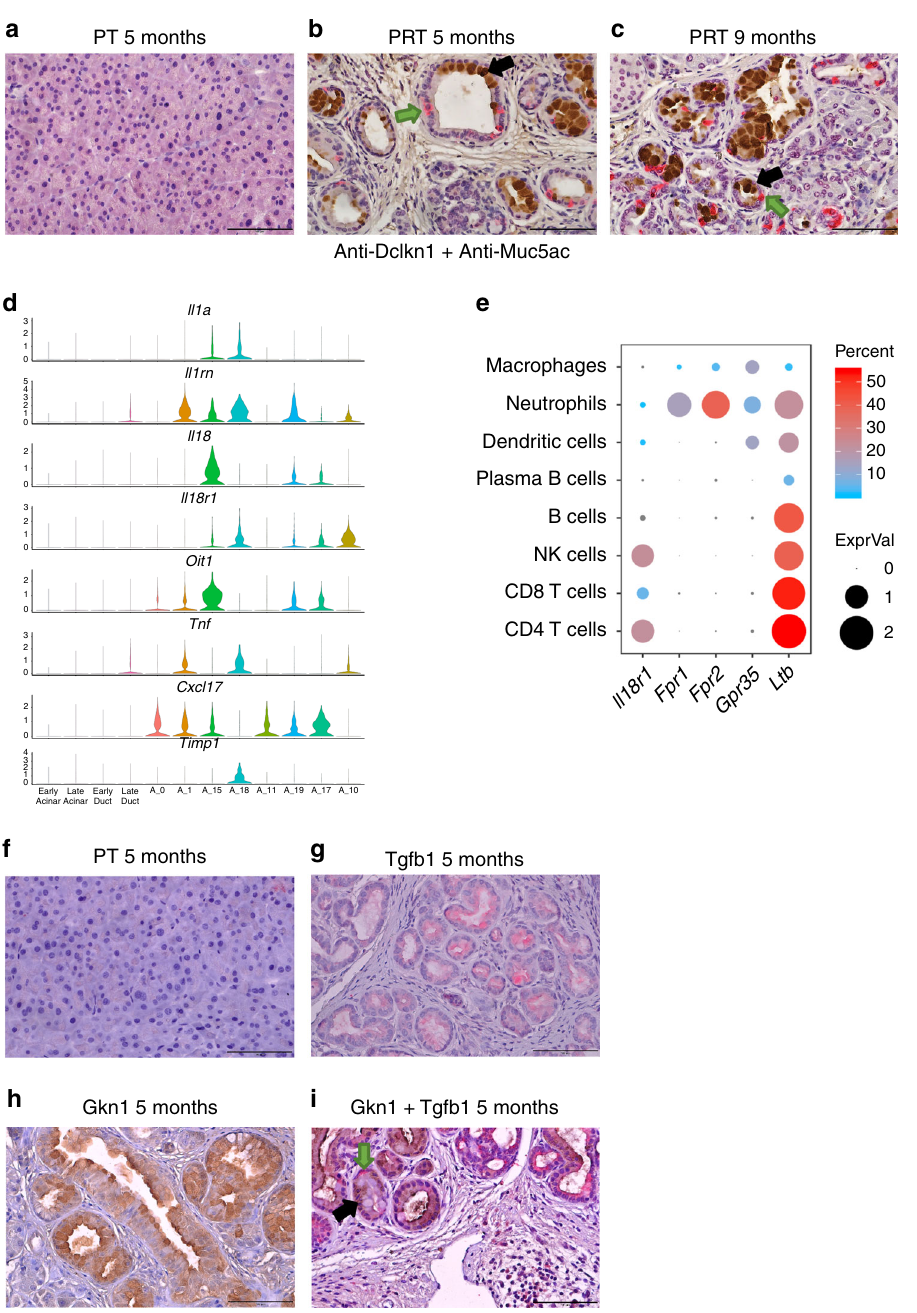
Fig. 5 Potential metaplastic cell – cell interactions and co-localization of different metaplastic cell types to the same PanINs. a – c Immunostaining of histological sections with anti-Dclk1 (red) and anti-Muc5ac (brown) antibodies. Arrows mark representative cells in the PanINs that stained positive with anti-Dclk1 (green arrow) or with anti-Muc5ac (black arrow). a Section taken from control, 5 months PT mouse, b section taken from 5 months PRT mouse, c section taken from 9 months PRT mouse. Scale bars 100 µ m. d Violin plot showing the expression level (normalized expression) of a selected set of secreted molecules and receptors. On the x -axis: Early acinar/ductal cells (control, 17 days and 6 weeks PTI samples), late (all other time points), and clusters of metaplastic cells. e Dot plot showing the expression of a set of receptors ( x -axis) across the different subset of immune cells ( y -axis). Immune cells subtypes are determined based on data presented in Fig. 7. The average expression level is shown by the size of the dot and the percentage of cells is indicated by the color. f , i Immunostaining of histological sections of the pancreas, double stain with anti-Tgfb1 (red) and with anti-Gkn1 (brown), representative cell marked with arrows, anti-Tgfb1 (green arrow), and anti-Gkn1 (black arrow), f control, 5 months PT mouse, i 5 months PRT mouse. g 5 months PRT mouse section, stained with anti-Tgfb1, h 5 months PRT mouse section, stained with anti-Gkn1. i . Scale bars 100 µ stomach-like cells (state 2, Fig. 6e and Supplementary Fig. 9a) or (ii) tumor cells (state 3, Fig. 6d and Supplementary Fig. 9b). The possibility of parallel progression to the two states is also supported by pseudo time analysis (Supplementary Fig. 9c).